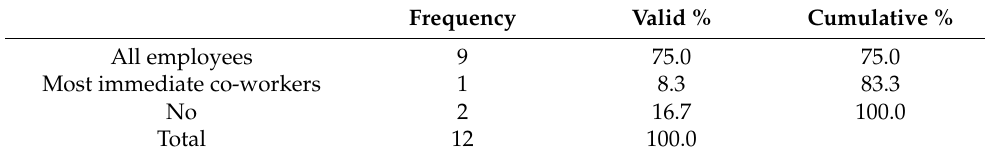
Table 6. Training on